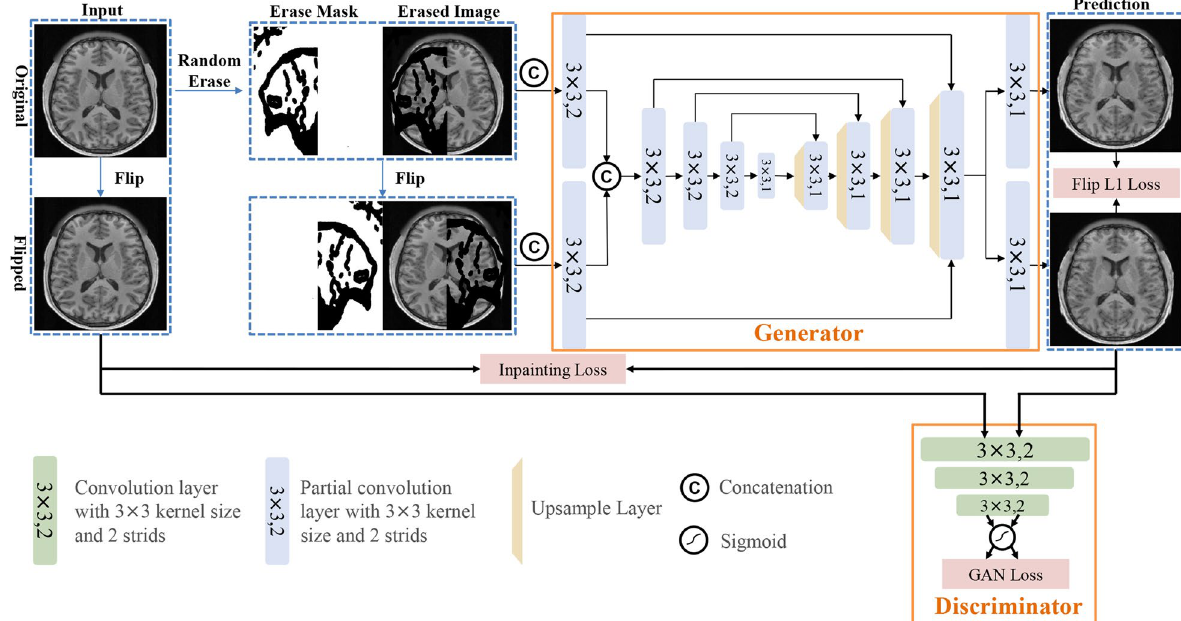
Fig. 3 The overall pipeline of the brain abnormality inpainting method for images from hydrocephalus patients. The framework consists of a UNet-like generator and a discriminator. The input of UNet is the concatenation of the random erased image with its erase mask and the flipped